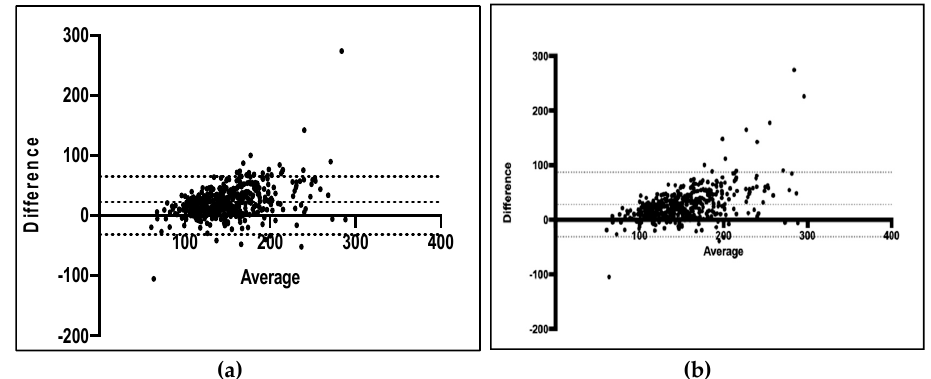
Figure 2. Differences between nutrient intake estimated from the food ‐ frequency questionnaire (first administration) and from the 7 ‐ day food records plotted against the mean from the two methods ( n = 460). For each participant, the difference in energy adjusted intakes between the FFQ (first administration) and the average of the 7 ‐ day food records is plotted against the mean intake from the two methods for: ( a ) Macronutrients, mean difference = 23.78 (95% CI of − 30.27, 68.96), ( b ) energy (kcal), mean difference = 393.2 (95% CI of − 441.3, 1228) with FFQ overestimating the nutrient intake compared to food diary.